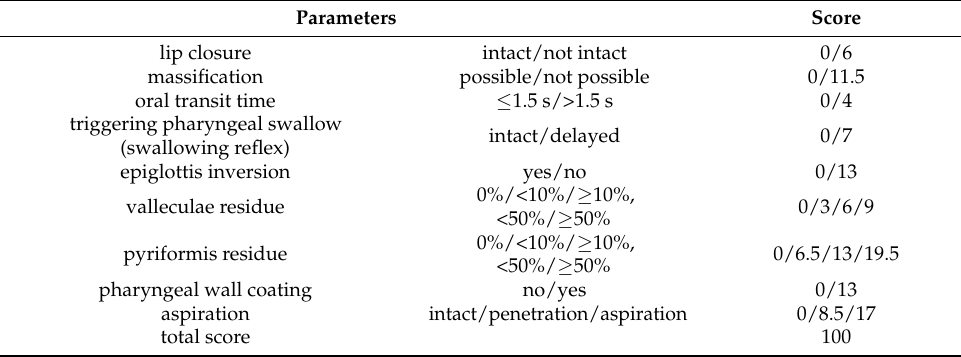
Table 1. Modified version of the Videofluoroscopic Dysphagia Scale.